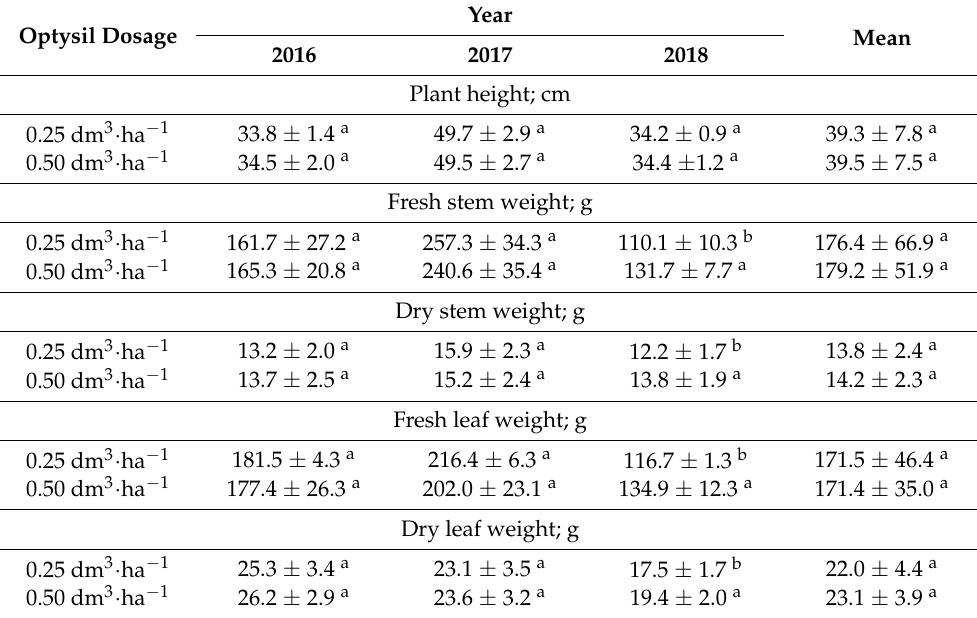
Table 4. Effect of Optysil dosage on plant height and above-ground plant biomass.